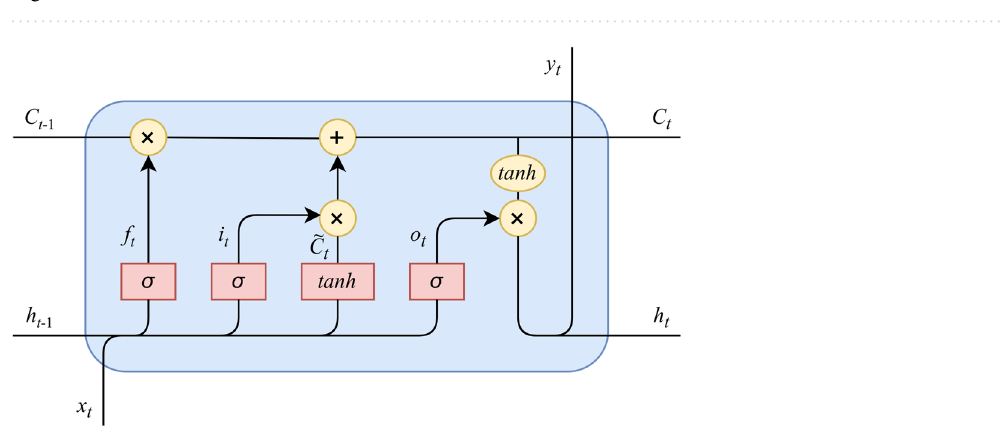
Figure 3. An unfolded RNN.